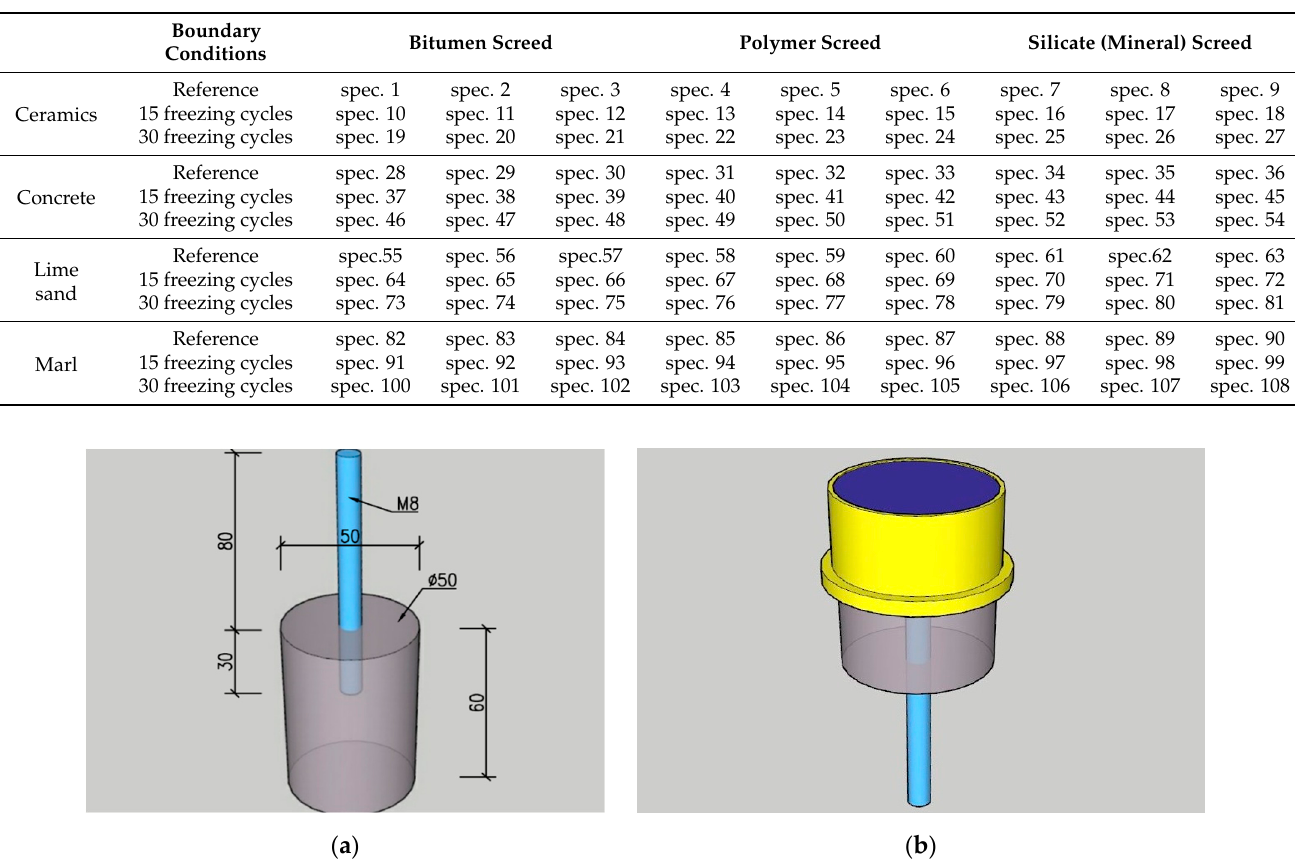
Figure 5. ( a ) Model of the specimen; ( b ) model of the prepared specimen with a delimiting ring and the applied waterproofing screed.